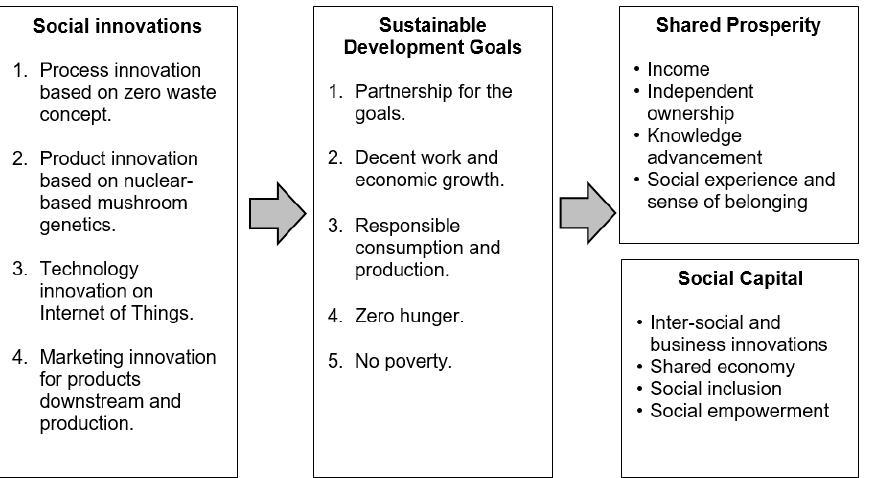
Figure 4. The social innovation model for sustainable development and greater social values.